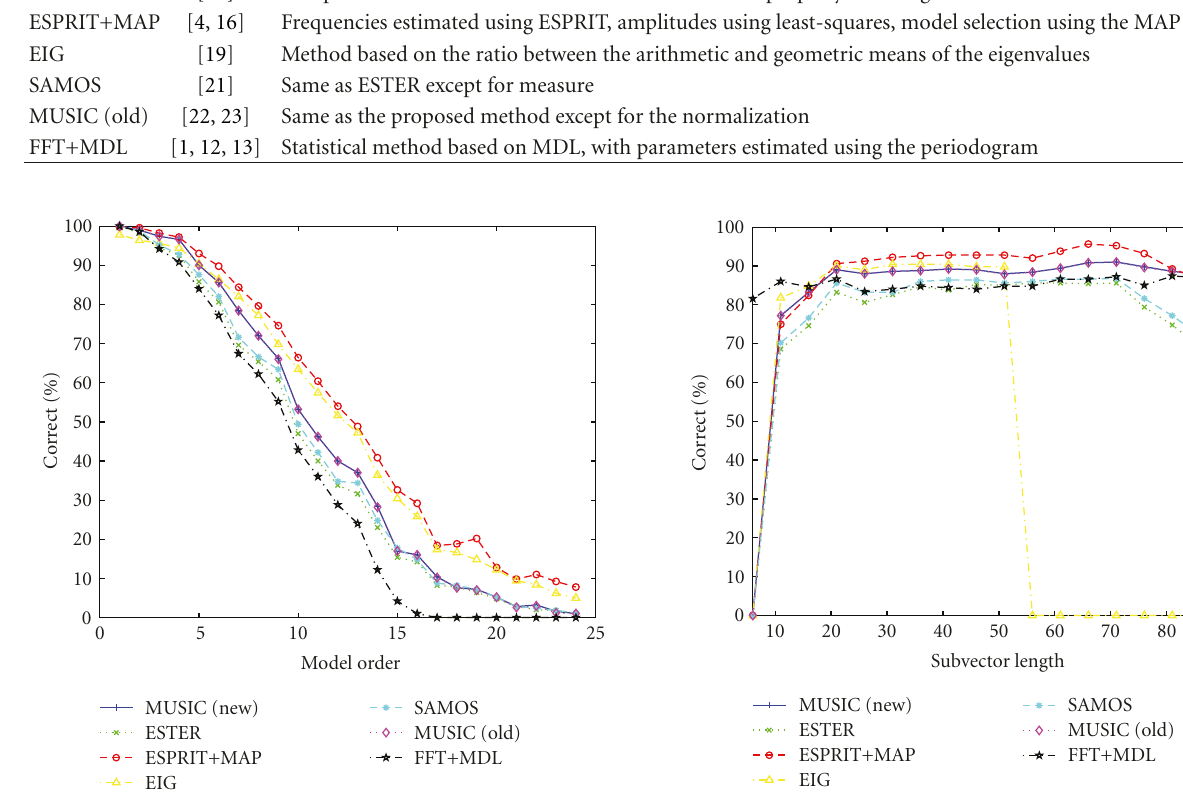
Figure 5: Percentage of correctly estimated model orders as a function of subvector length with SNR = 20dB and N = 100.